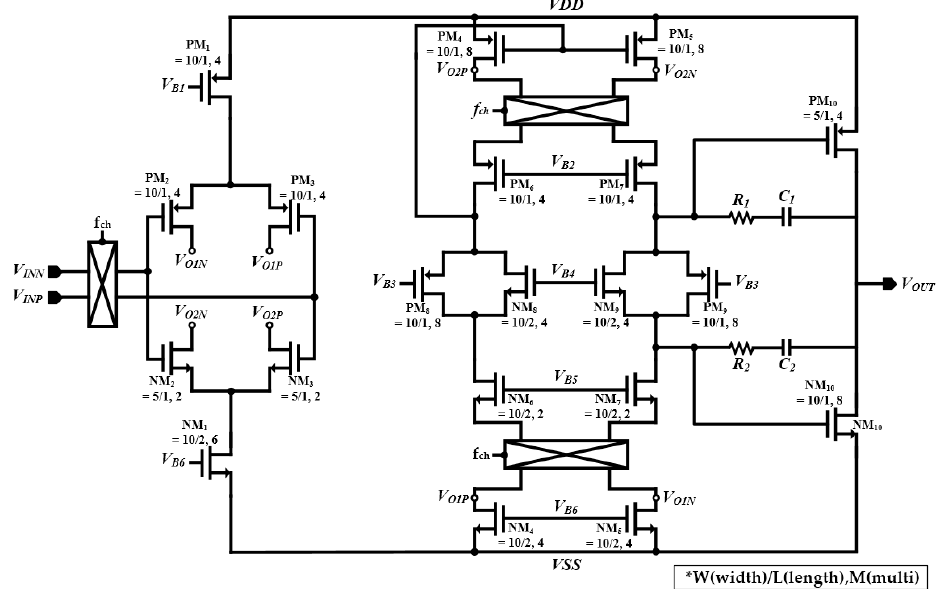
Figure 6. Schematic of the single-ended chopper amplifier.